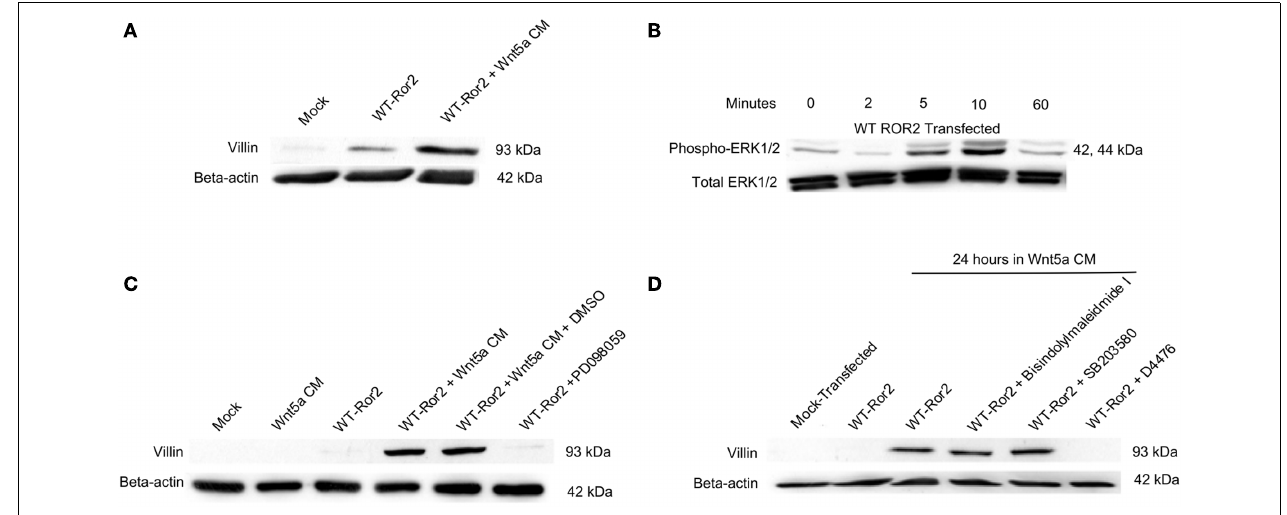
Wnt5a-enhanced villin protein expression was prevented in similarly treated cells, in the presence of PD 098059 (10 μ M). (D) However, increased villin protein levels were maintained inWnt5a-challengedWT Ror2-cells, despite the presence of either Bisindolylmaleimide I (1 μ M) or SB 203580 (10 μ M). Yet, in the presence of D4476 (100 μ M),Wnt5a-induced villin protein expression was prevented For all experiments described,Western blotting for immunoreactive β -actin was performed to demonstrate equal loading. These experiments reflect results from similar experiments performed